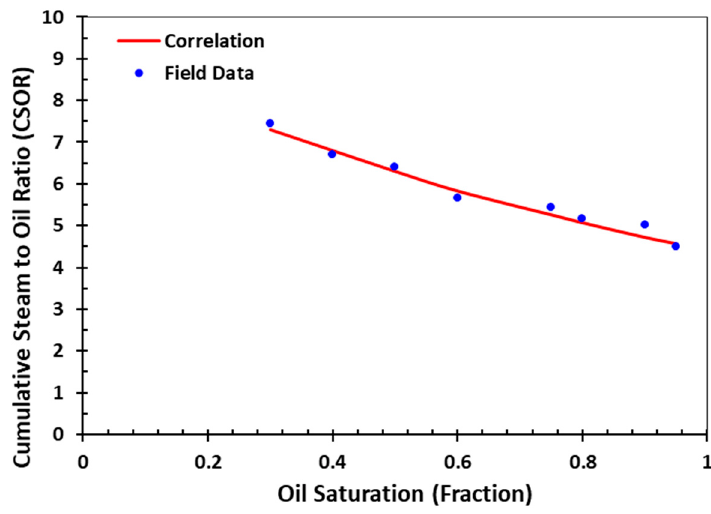
Figure 7. CSOR vs. oil saturation for the database analyzed. Figure 6. CSOR vs. oil saturation for the database analyzed. Figure 6. CSOR vs. oil saturation for the database analyzed.